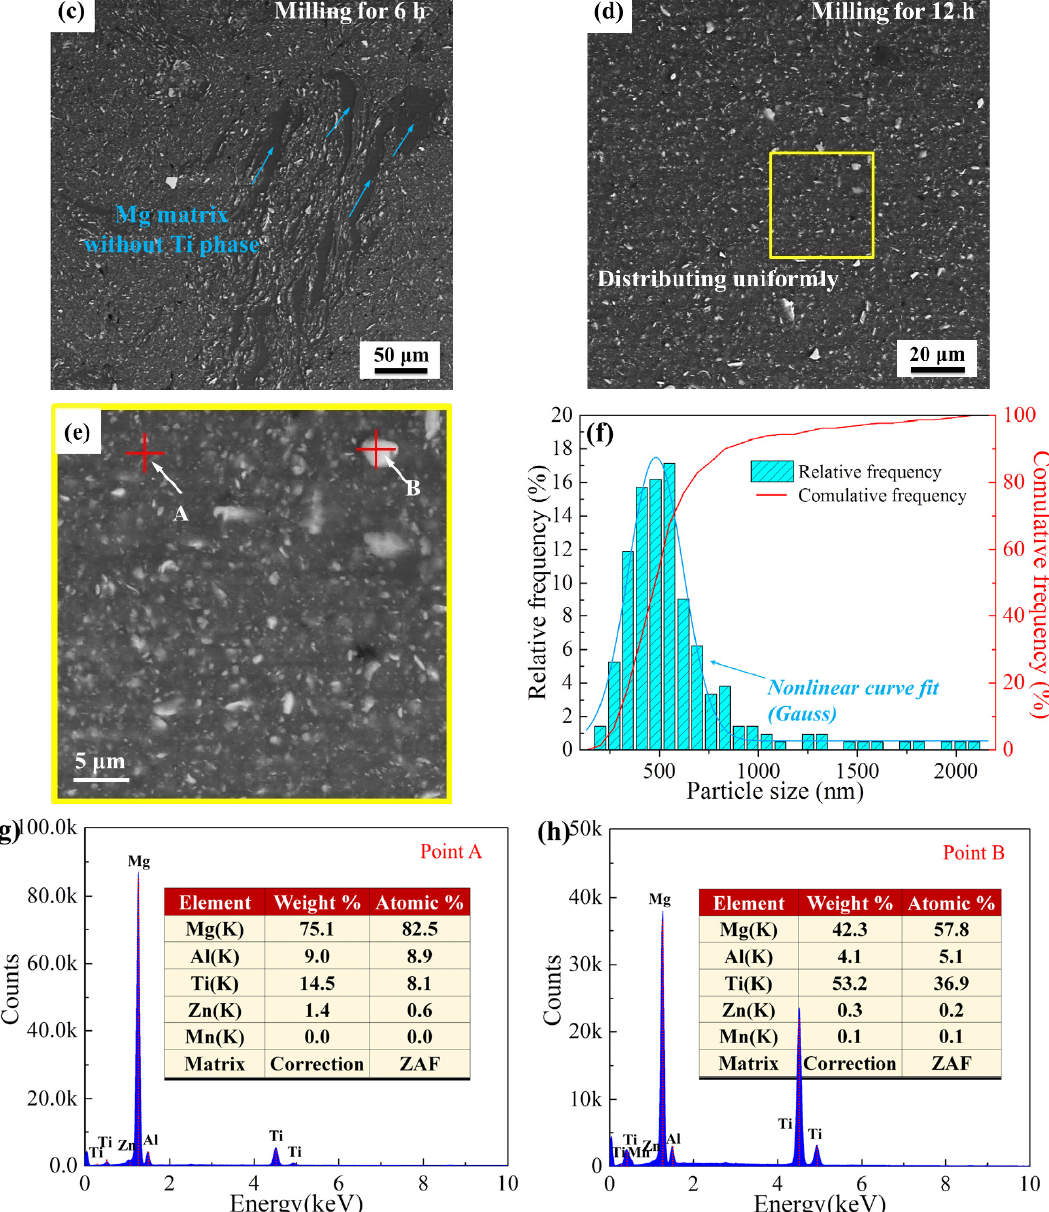
Figure 5. BSE images of milled composite powers for various milling times: ( a ) 1 h; ( b ) 2 h; ( c ) 4 h and ( d , e ) 12 h, ( f ) particle size statistics of ( e ) and ( g , h ) EDS results of A and B in ( e ).